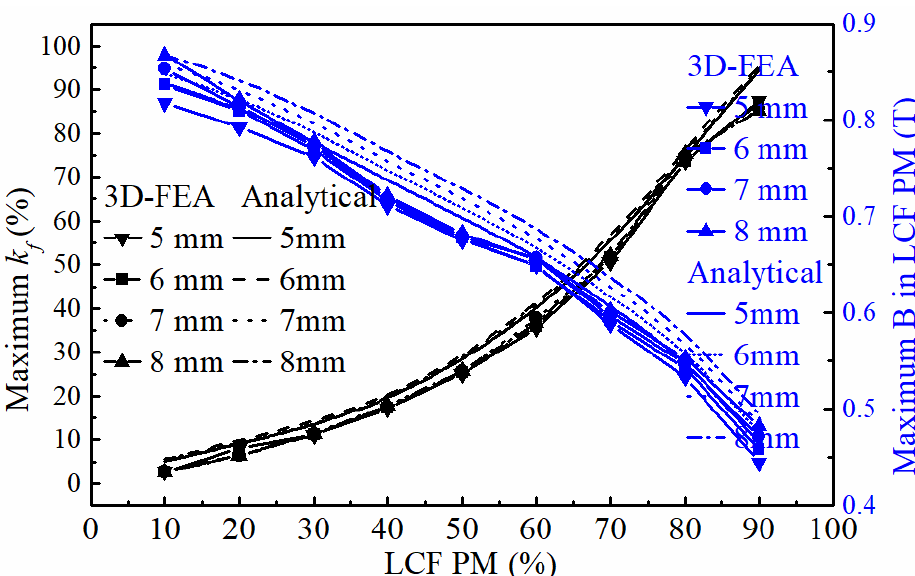
Figure 5. Maximum flux regulation capability and magnetic flux density inside the PMs as a function of the percentage of the LCF PM under varying thicknesses of the SPM.